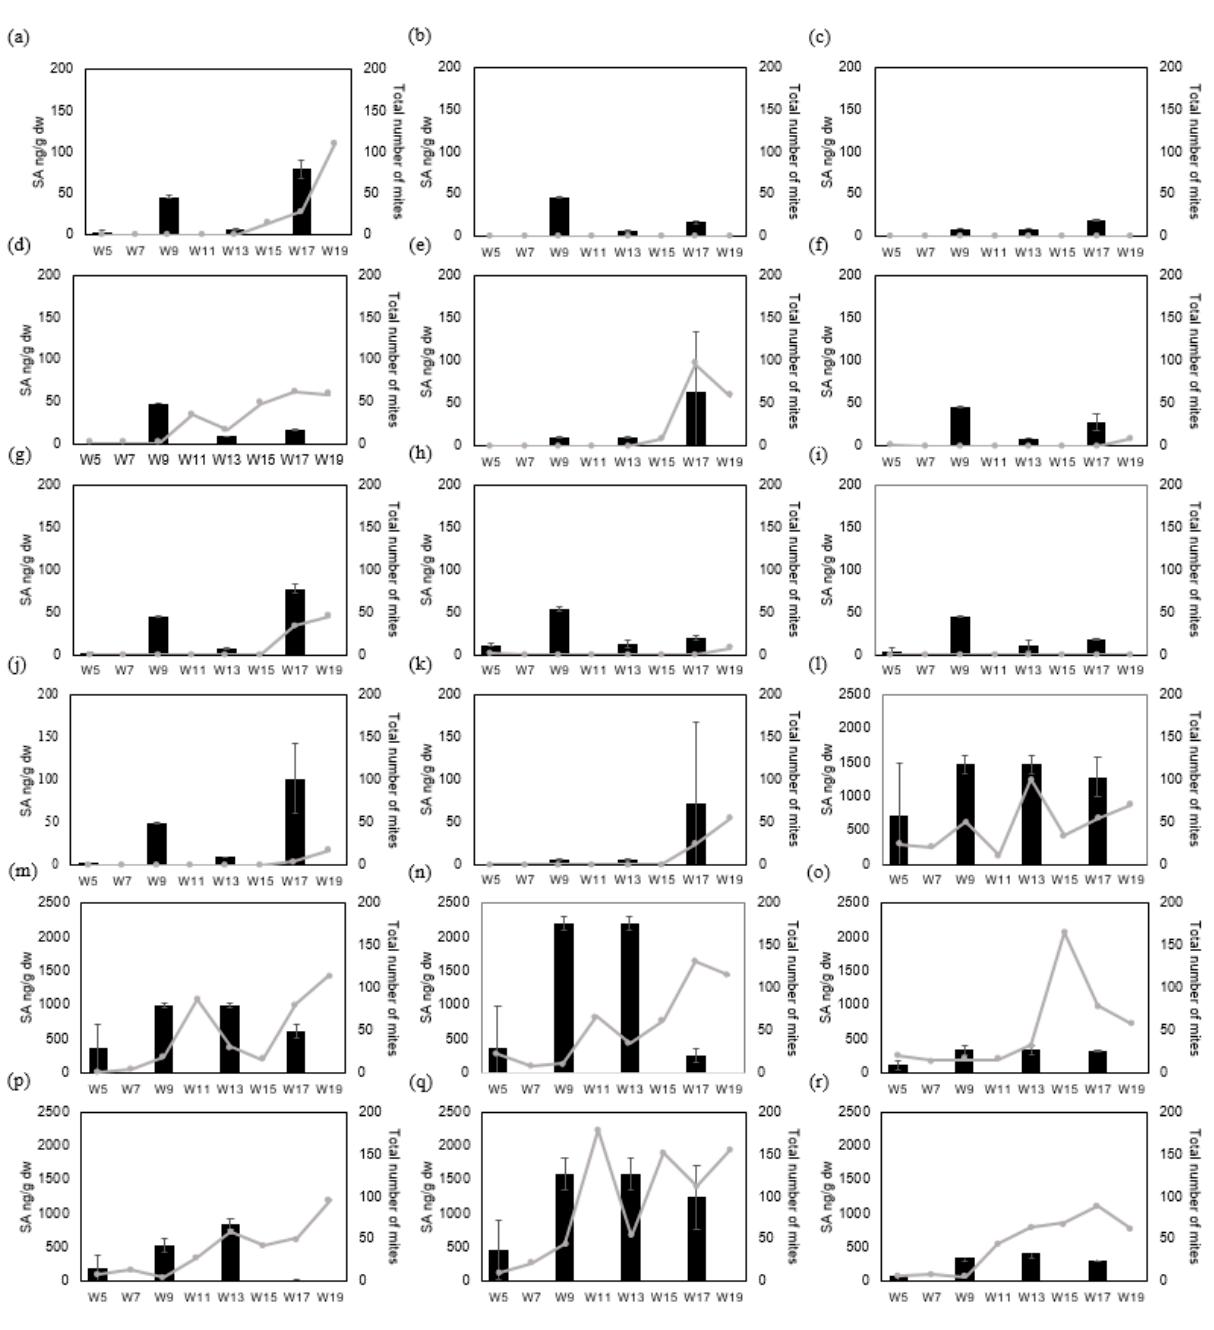
Figure 3. Experiment 3: mite numbers of Polyphagotarsonemus latus (total of 3 shoot tips) counted on different sampling dates (every two weeks, 15 time points) and levels of salicylic acid (SA) (+ SD) ( n = 3) in 18 cultivars of pot azalea. With low SA levels (Y-axis up to 200 ng/g dw): ‘Amélie’ ( a ), ‘Elien’ ( b ), ‘Huelsten’ ( c ), ‘Inka’ ( d ), ‘Luntera’ ( e ), ‘Mevrouw Edmond Troch’ ( f ), ‘Mevrouw Gerard Kint’ (picotee) ( g ), ‘Nordlicht’ ( h ), ‘Sachsenstern’ ( i ), ‘Tamira’ ( j ) and ‘Thesla’ ( k ). With high SA levels (Y-axis up to 2500 ng/g dw): ‘Fluostern’ ( l ), ‘Franziska R.’ ( m ), ‘Leonardo’ ( n ), ‘Mevrouw Gerard Kint’ (red) ( o ), ‘Michelle Marie’ ( p ), ‘Otto’ ( q ) and ‘Renato’ ( r ).